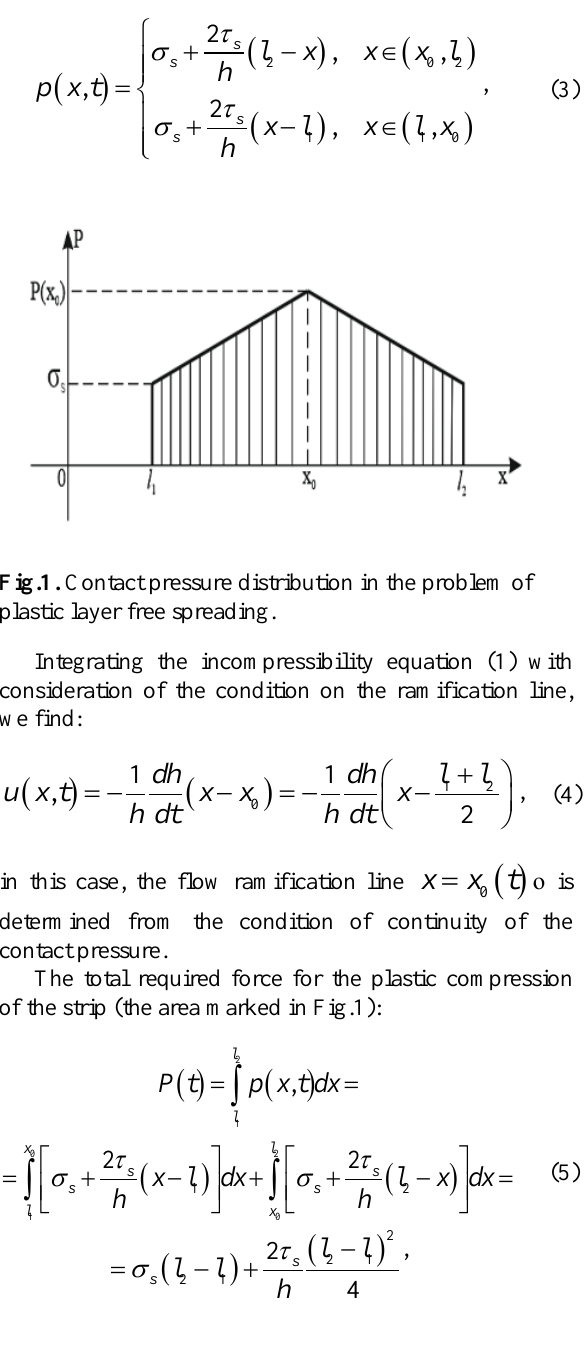
Fig.2. Free spreading of the strip with movable ends.